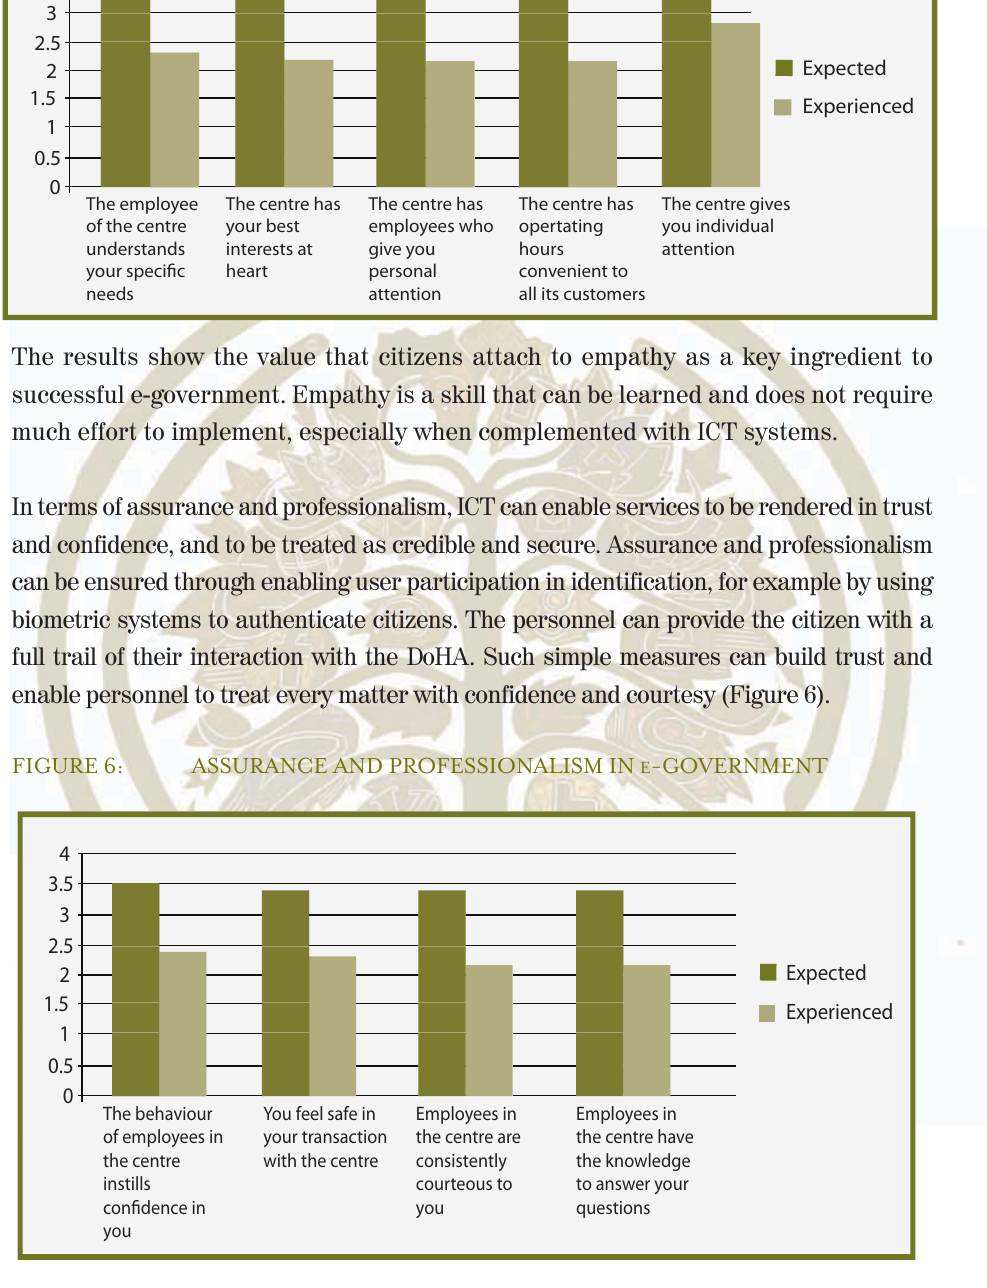
FIGURE 5: EMPATHY IN RELATION TO E -SERVICES AND E -GOVERNMENT